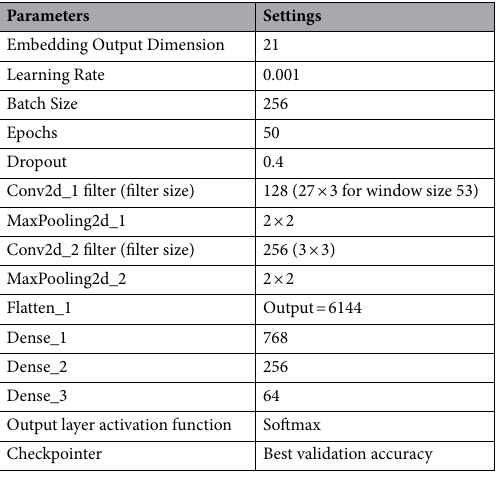
Table 2. Parameters description of CNN model with embedding